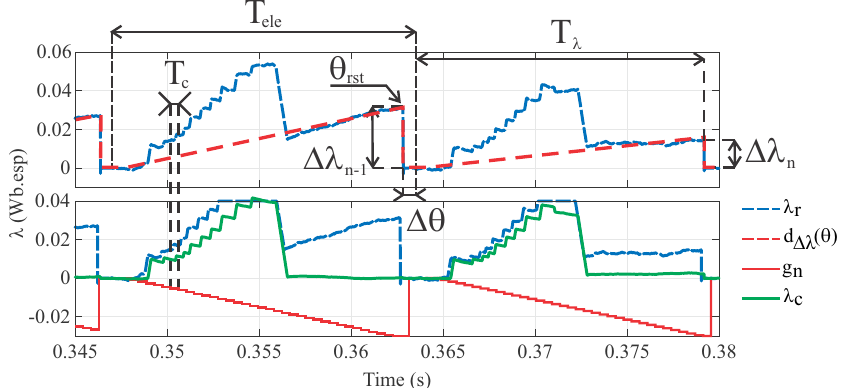
Figure 6. Graphical illustration of the quantities in the proposed drift cancellation method.